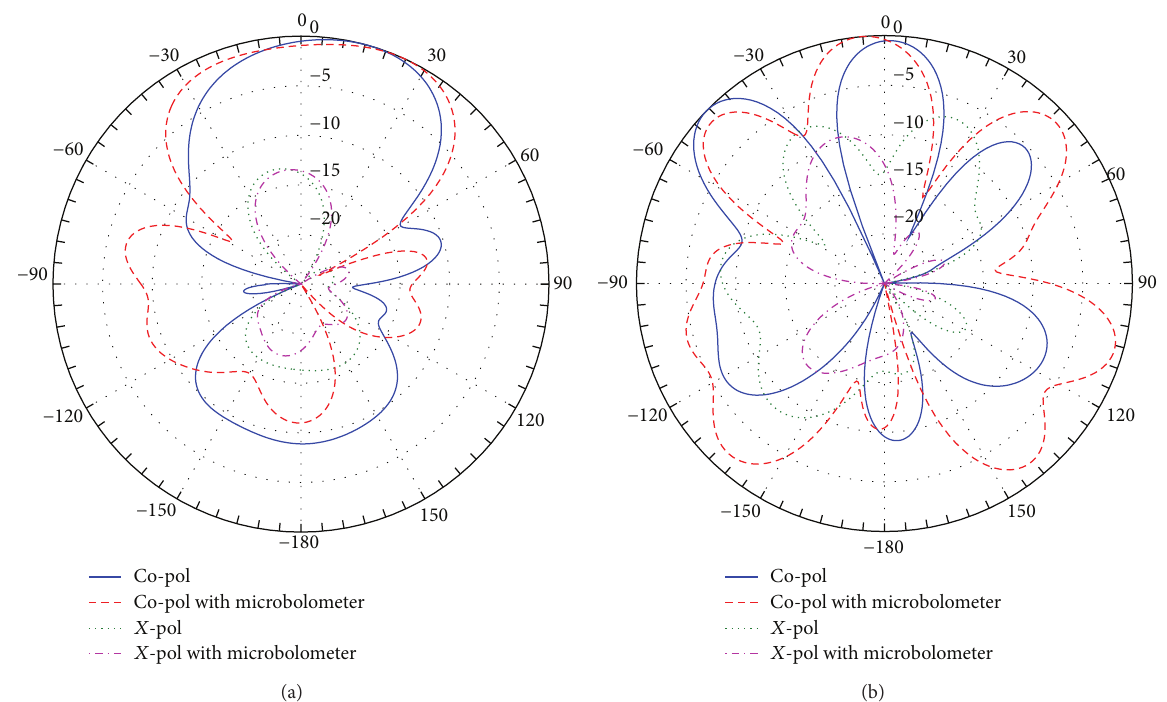
Figure 5: Simulated copolarization and cross-polarization radiation patterns in (a) 𝑌𝑍 plane and (b) 𝑋𝑌 plane at 𝑓 = 94 GHz for the Quasi- Yagi loop array antenna prototype I with and without microbolometer.